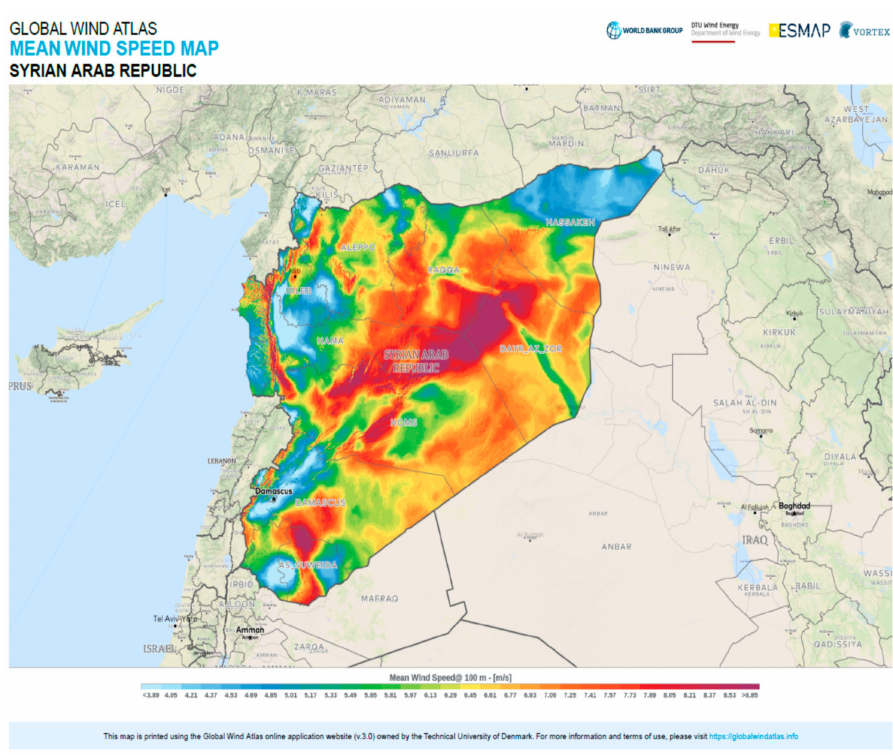
Figure 9. Mean wind speed in Syria